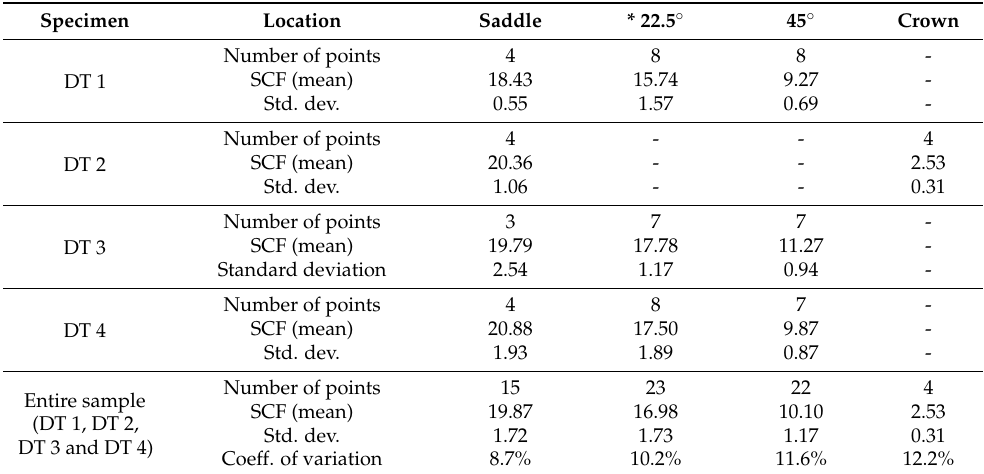
Table 3. SCFs from experimental work (present data).